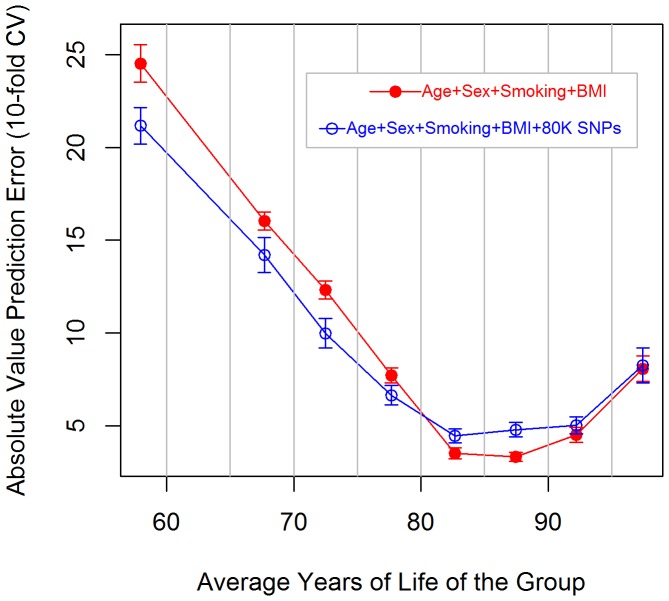
Absolute value CV prediction error versus range of YL.Circles represent the average absolute value prediction error for each group of YL (YL≤65, 65<YL≤70,..,YL>95); and vertical bars represent the 95% confidence interval defined by the average absolute value prediction error ±1.96×SE.